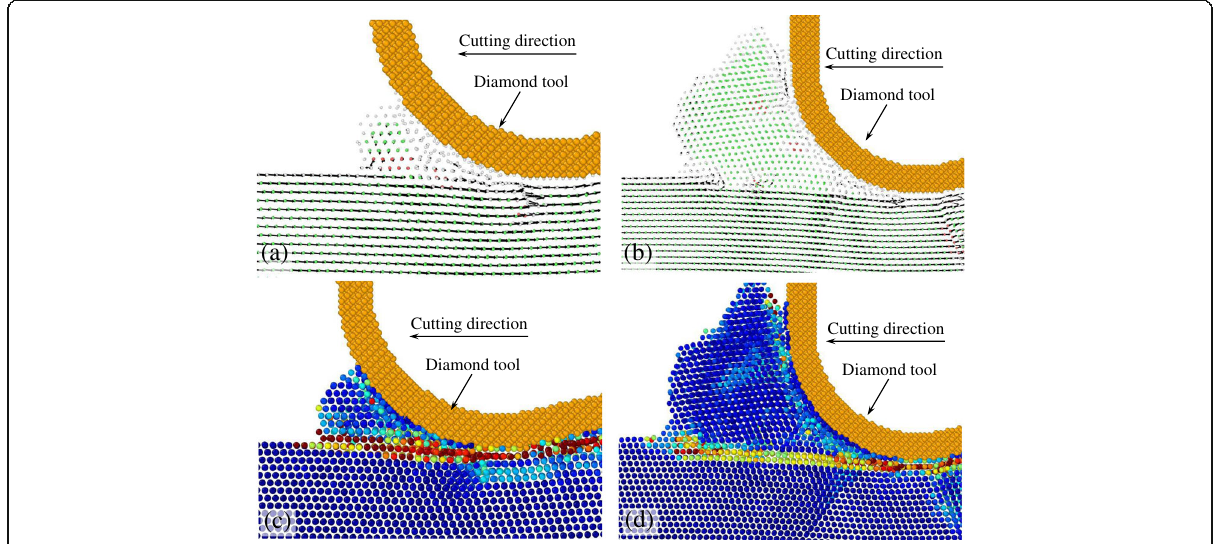
Fig. 10 Displacement vector of atoms at the plane B-B, cutting direction of {111} < 11 – 2 > and the feed of ( a ) 1.5 nm and ( b ) 3.75 nm; ( c ) and ( d ) corresponding shear strain